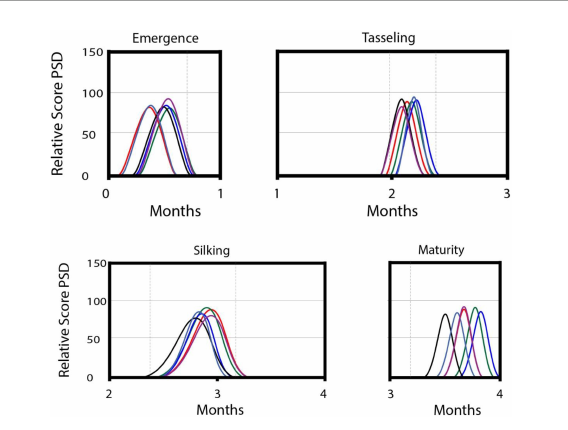
FIGURE2 An illustration of the impact of phenology forcing on phenology shift of four phenophases of maize crop. Time considered in the study has been considered in months and mentioned on the x -axis, while the score of phenology shift density (PSD) has been mentioned on the y -axis. The role of each sub-class of EEEs has been represented with differentially colored lines; high temperature (red); low temperature (green); high precipitation (blue) low precipitation (purple); drought (black); wind